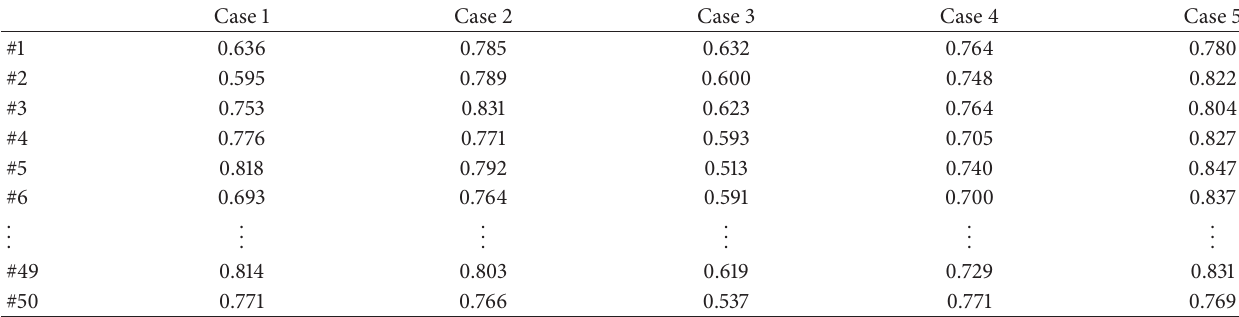
Table 4: The Dykstra-Parsons coefficients of 50 fields for each case.